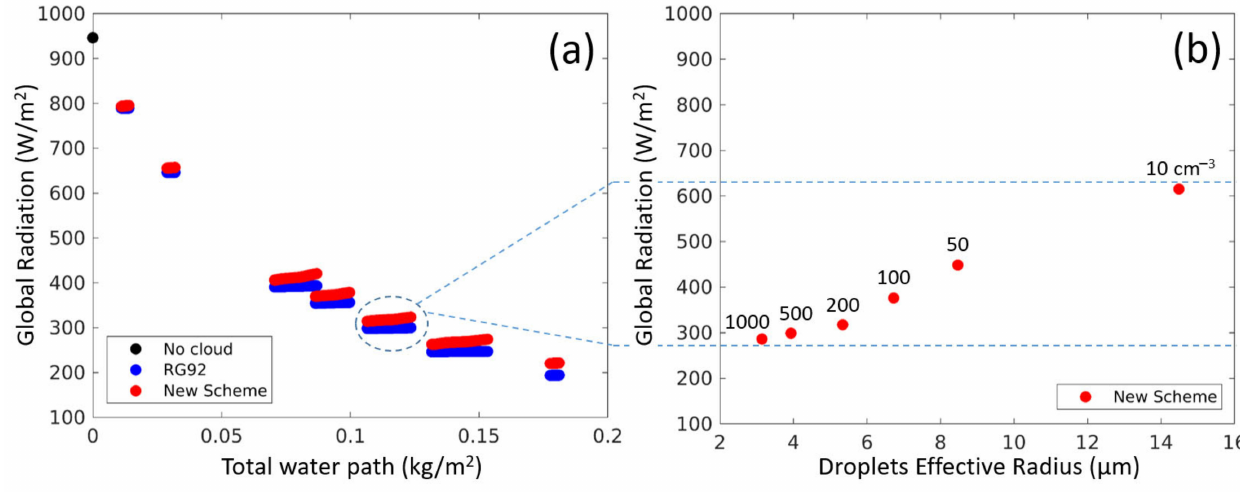
Figure 6. ( a ) Global radiation versus liquid water path for 7 experiments of warm stratus assuming droplet number concentration of 500 cm − 3 . The clear sky reference is marked by a black dot. The default COSMO radiation scheme RG92 (blue dots) and the new scheme (red dots) are presented. ( b ) Global radiation (red dots) in the new scheme versus cloud-averaged droplets effective radius for experiment 5 of warm stratus (see Table 1) marked by the dashed circle. The red dots from left to right correspond to cloud droplets number concentrations of 1000, 500, 200, 100, 50, 10 cm − 3 . The range of variation in global radiation due to change in effective radius is marked by dashed